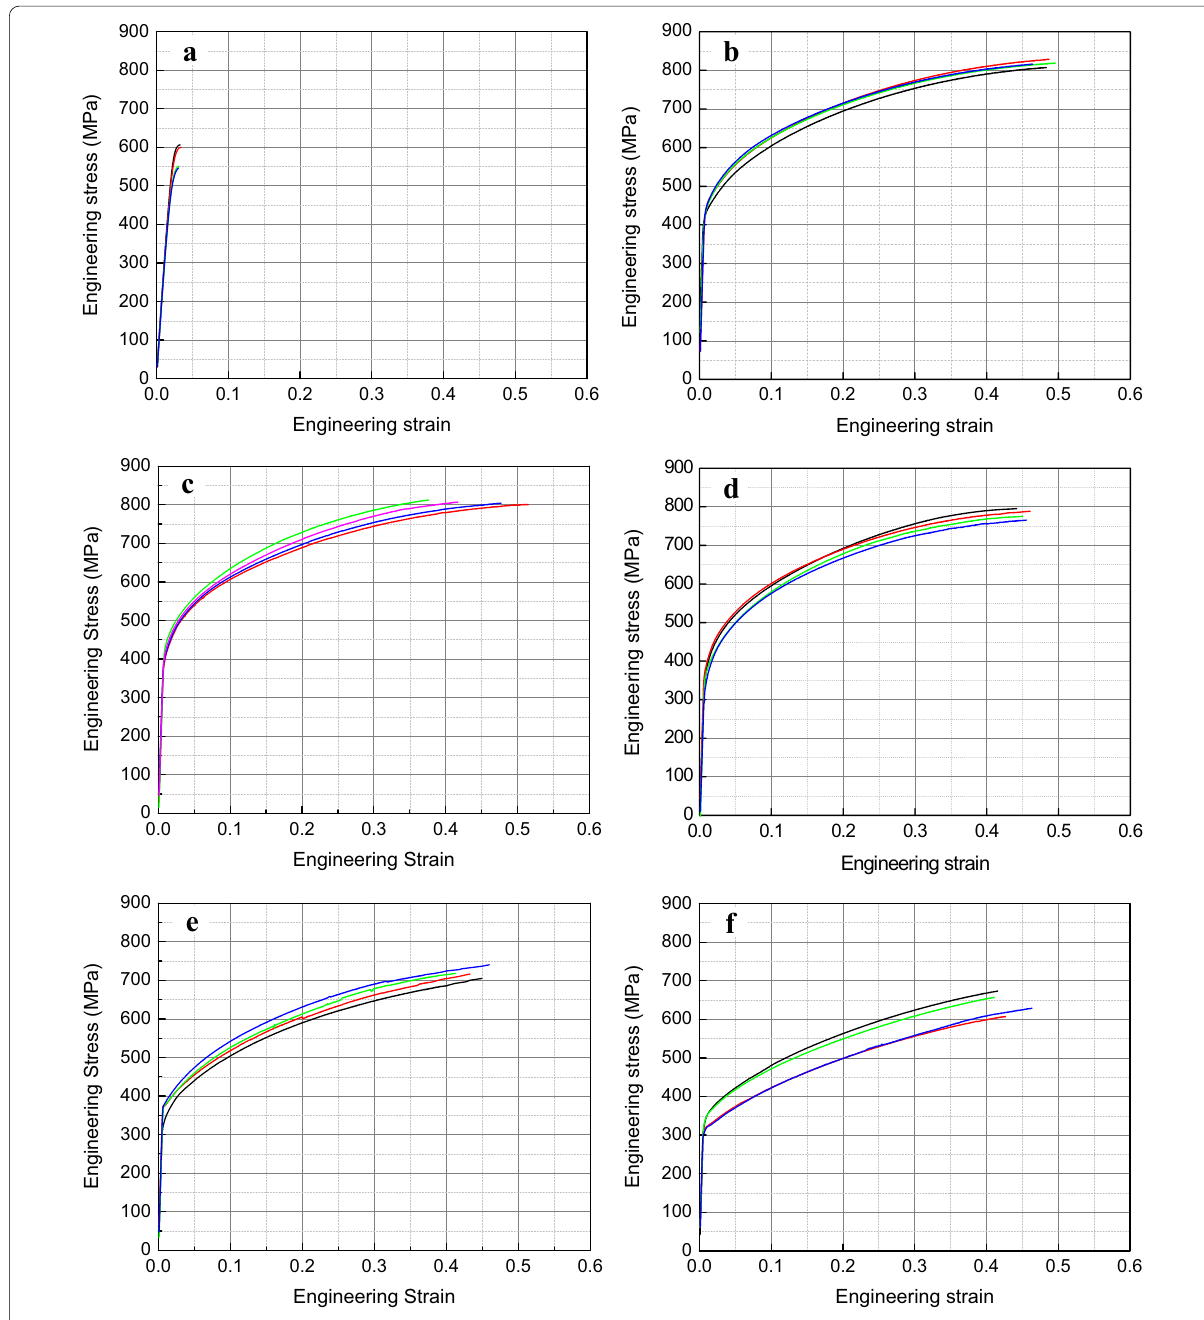
Figure 6 Typical tensile curves of the specimens: a as-received, b A850, c A900, d A950, e A1000, f